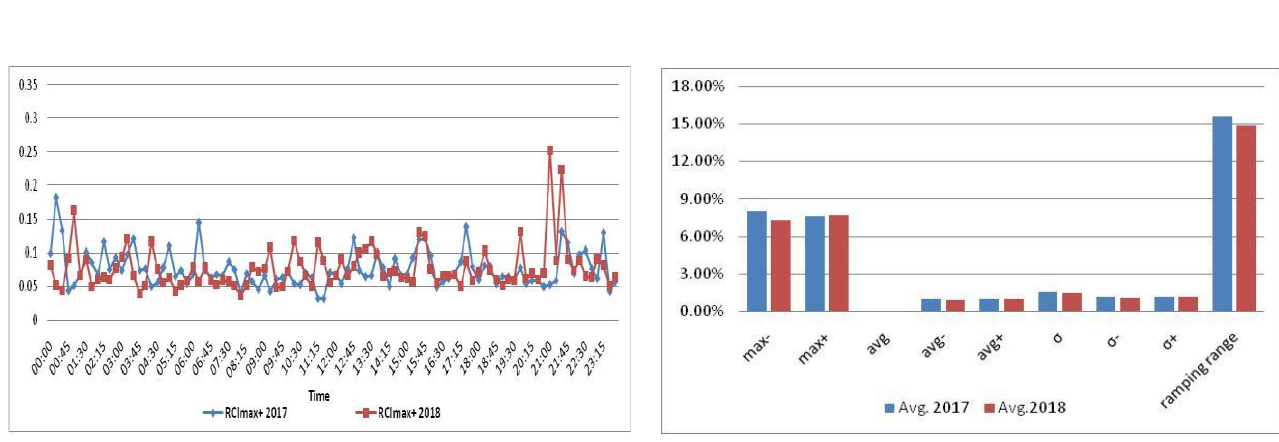
Figure 22. Average values of vertical analysis